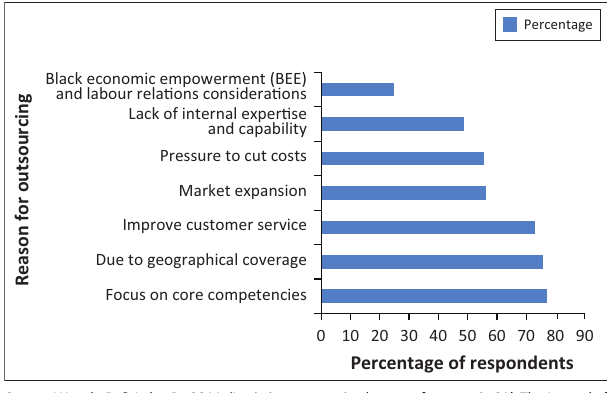
FIGURE 1: Percentage of respondents